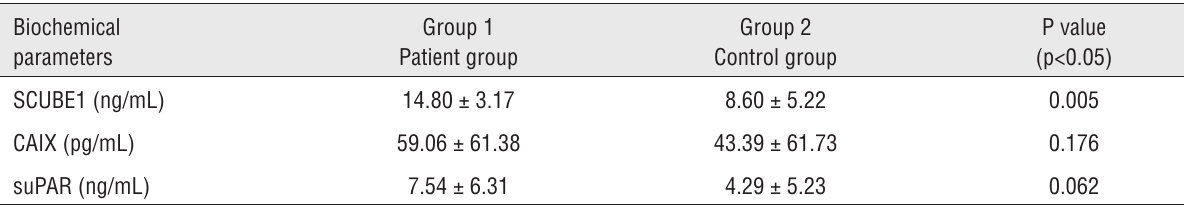
Table 2 - comparison of biochemical parameters in the patient and control groups.